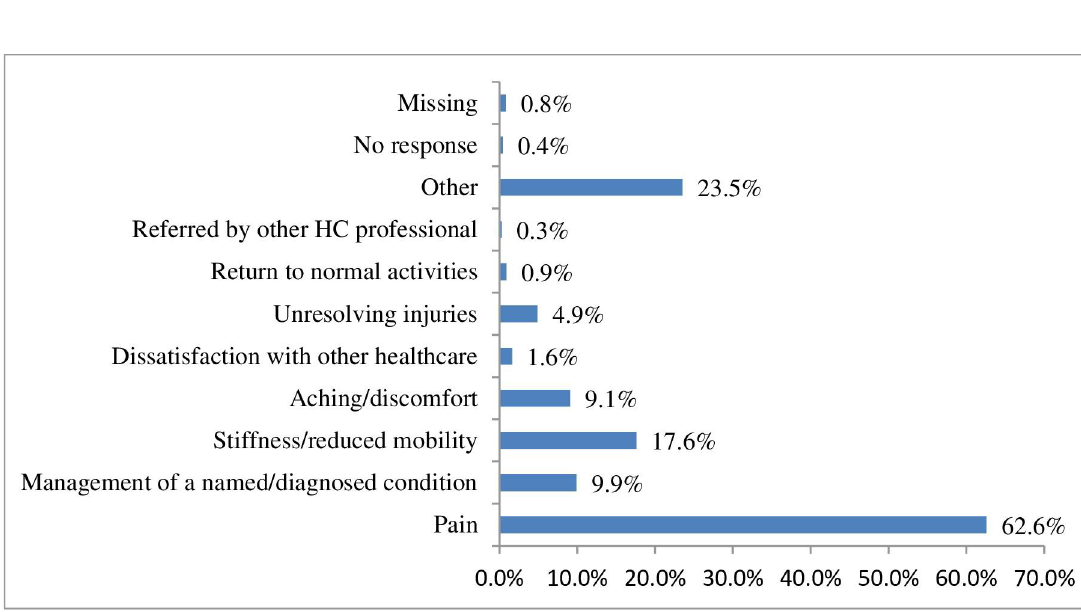
PLOS ONE | https://doi.org/10.1371/journal.pone.0249719 April 16,